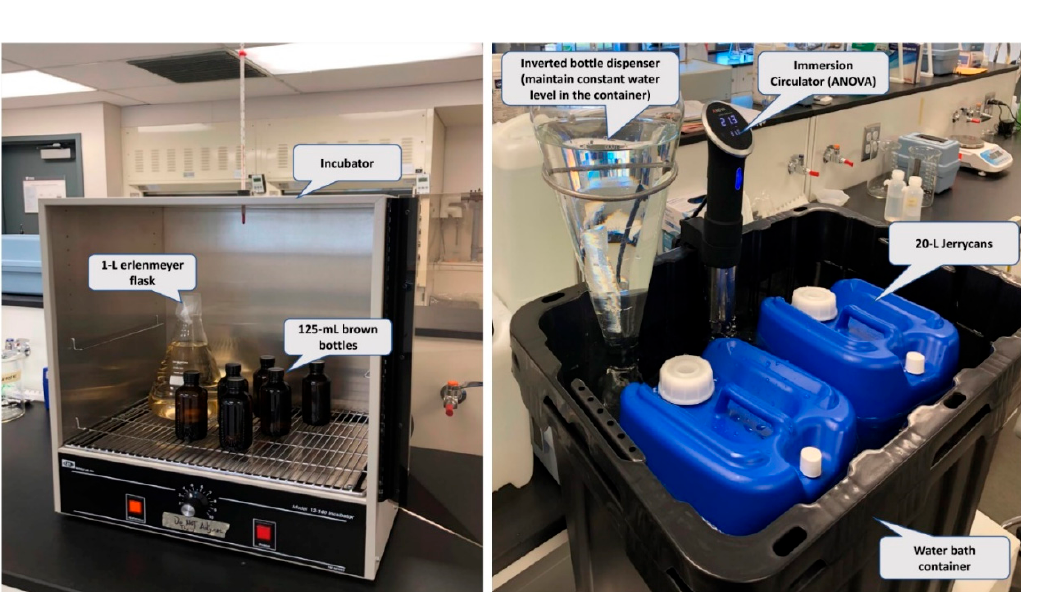
Figure 1. Experimental setup for chlorine decay tests in bulk “brown bottles” tests ( left ) and in jerrycans ( right